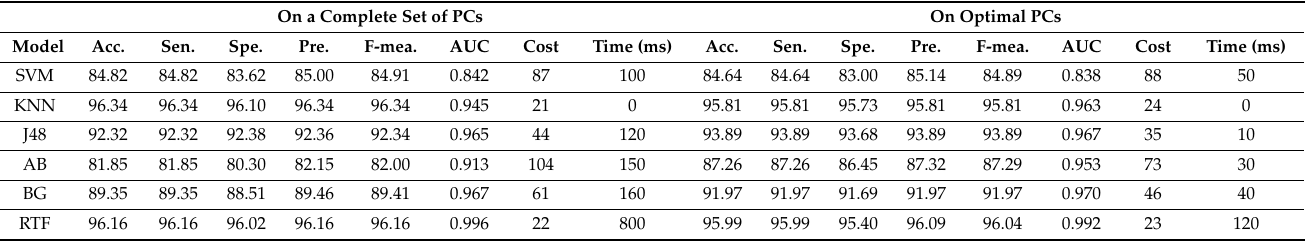
Table 7. Performance comparison of machine learning algorithms on a complete and optimal set of principal